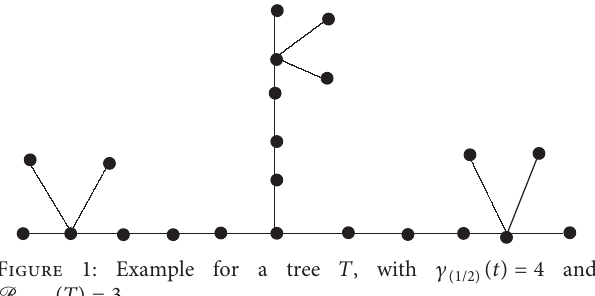
Figure 1: Example for a tree T , with c ( T ) � R ( 1/2 )